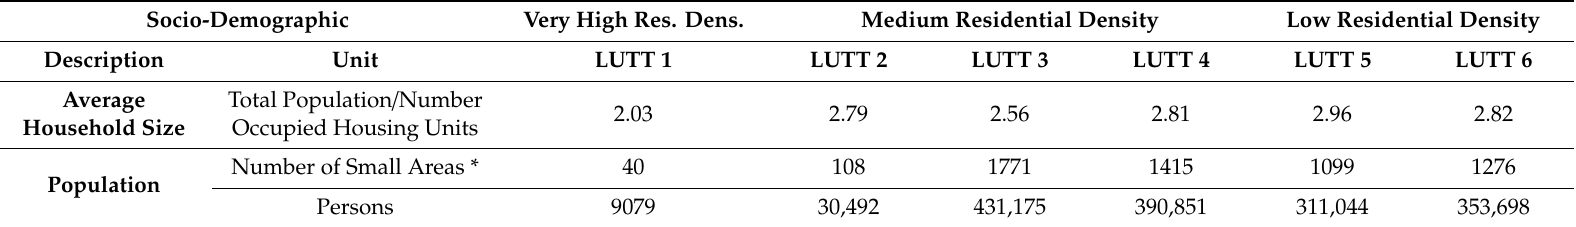
Table 2. Key Socio-Demographic Characteristics of each